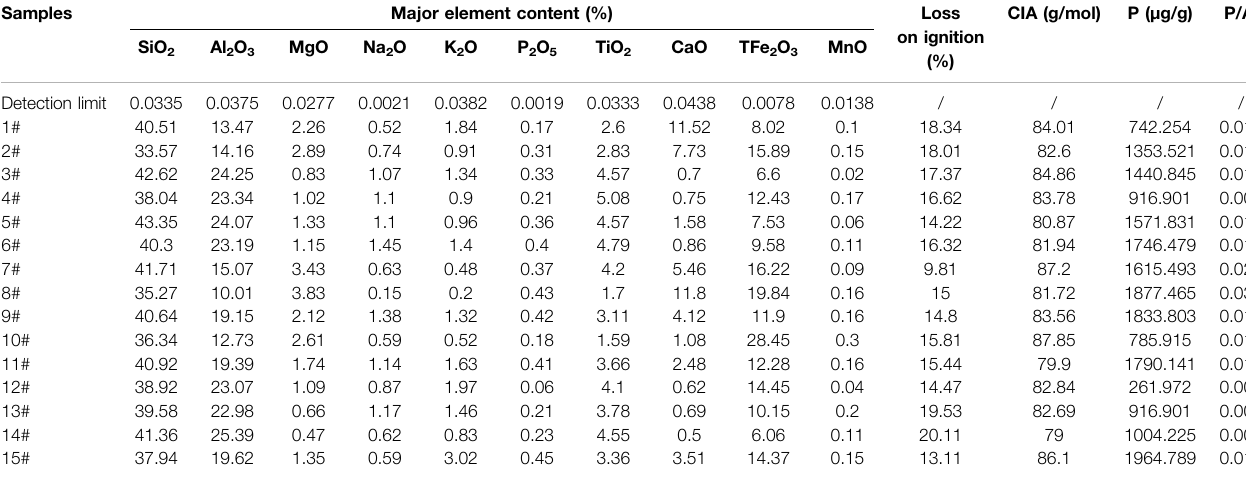
TABLE 2 | Major element oxide contents of different Longtan Formation samples in the study area (%). Samples Major element content (%) Loss